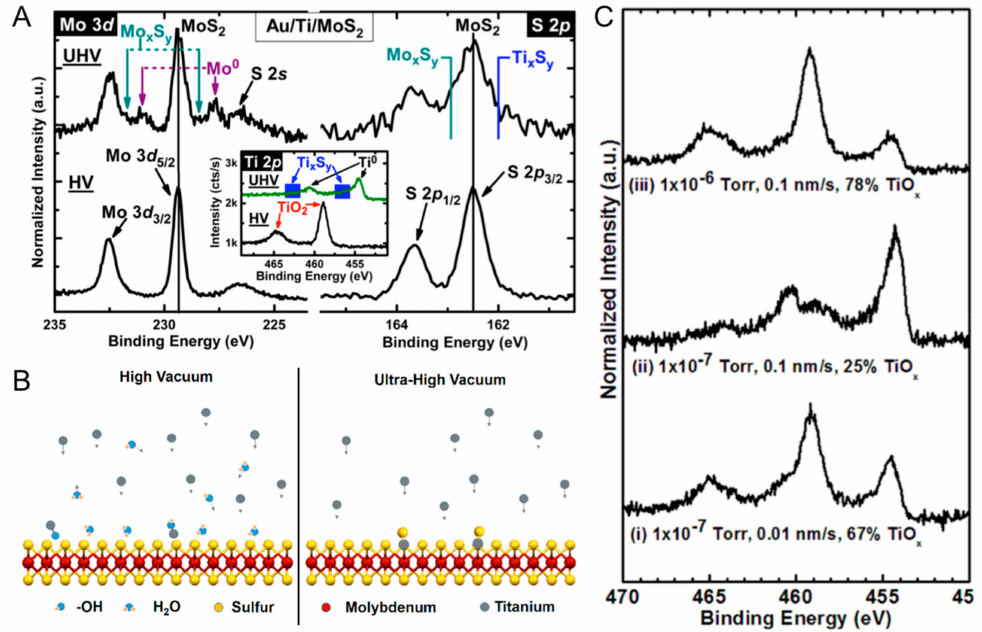
Figure 4. ( A ) Mo 3d, S 2p, and Ti 2p (inset) for UHV Ti–MoS 2 exposed to air for 20 minutes. The